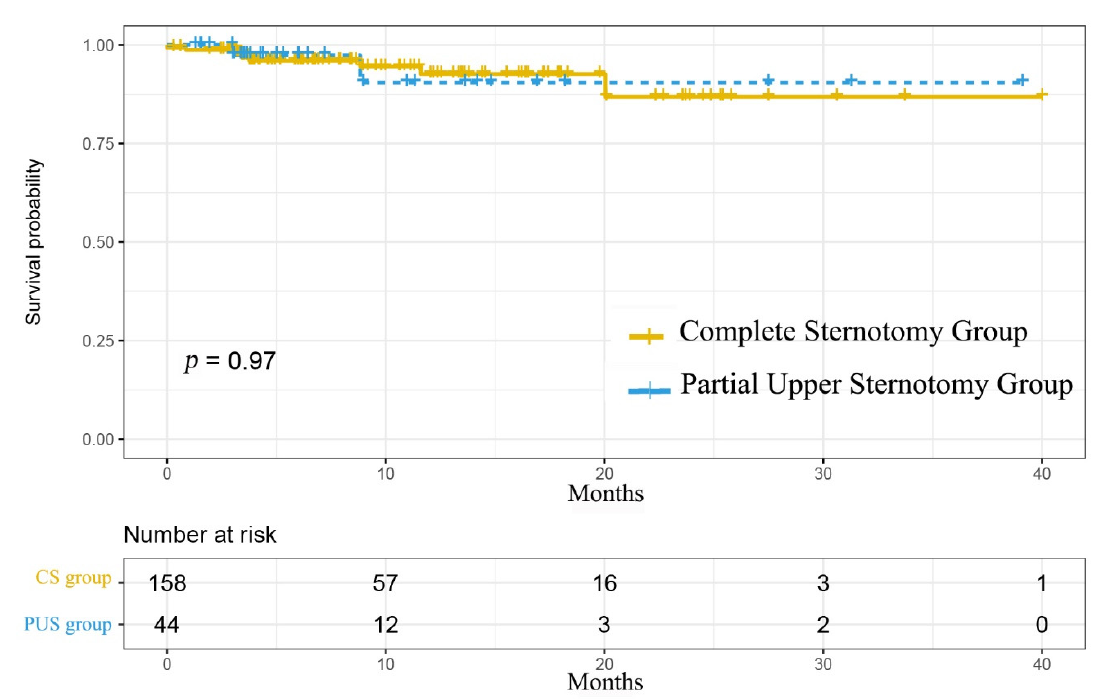
Figure 4. Kaplan–Meier curve for freedom from reoperation or moderate to severe aortic insufficiency. Table 4. Echocardiographic data of the propensity-matched cohort.